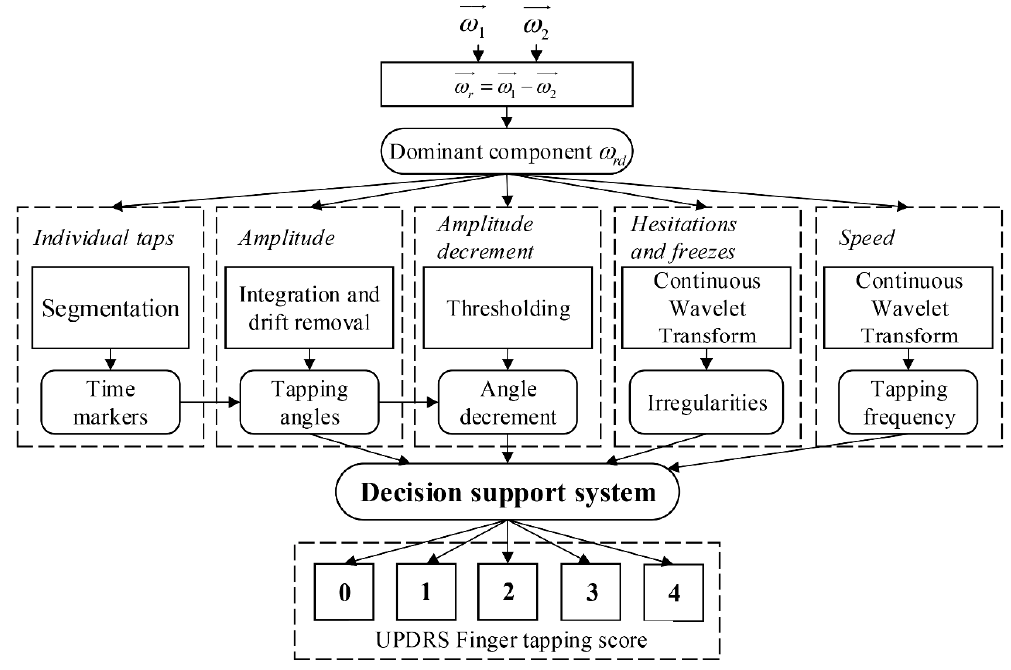
Figure 2. Block diagram of the expert system for UPDRS finger-tapping score calculation.